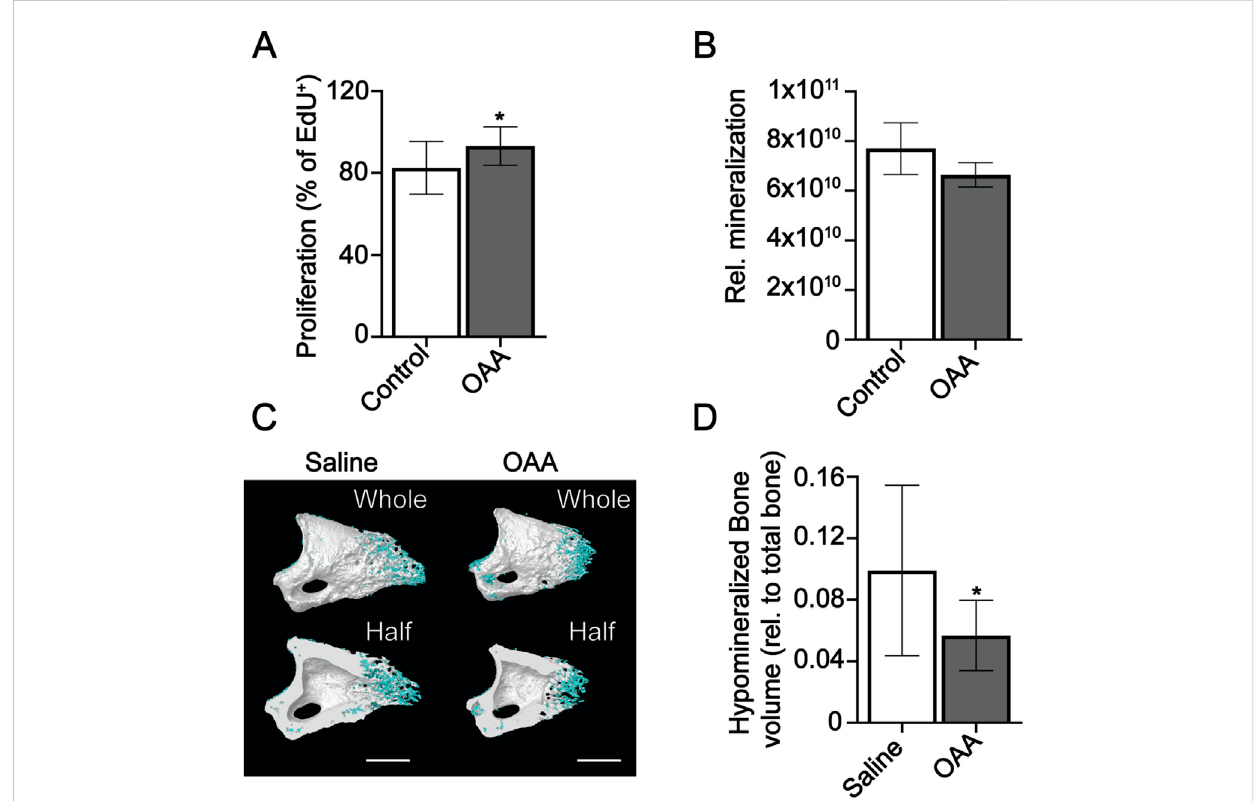
FIGURE 4 OAA increases proliferation and delays mineralization. (A) Proliferation of MC3T3 undifferentiated osteoprogenitors in OAA-treated and untreated cells.GraphrepresentsmeannumberofEdU + cells/totalcells±SD. n =11-12.* p < 0.05. (B) Quanti fi cationofmineralizationinOAA-treatedanduntreated differentiated MC3T3 cells. Graph represents mean Osteoimage pixel intensity/area. n = 4-5. (C) Radiographic images of whole and bisected digits in young mice at day 14 following administration of saline (Control) and OAA from day 10 – 14 following amputation of the distal P3. Mineralized bone shown in white, hypomineralized bone shown in blue. Bar 200 µm. (D) Quanti fi cation of hypomineralized bone (relative to total bone). n = 8 – 12. * p <